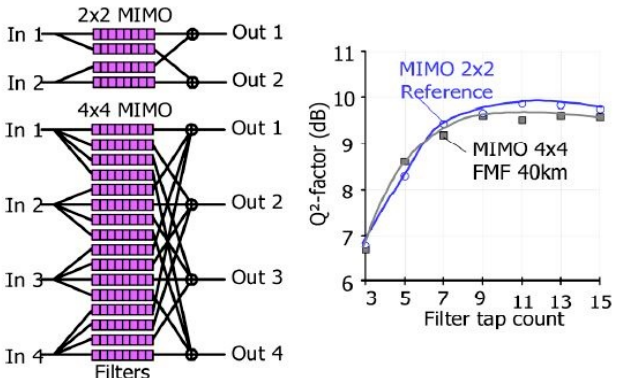
Figure 24. The finite impulse response (FIR) filter illustration, along with Q 2 -factor vs. tap number for both 2 × 2 and 4 × 4 MIMO cases [42].